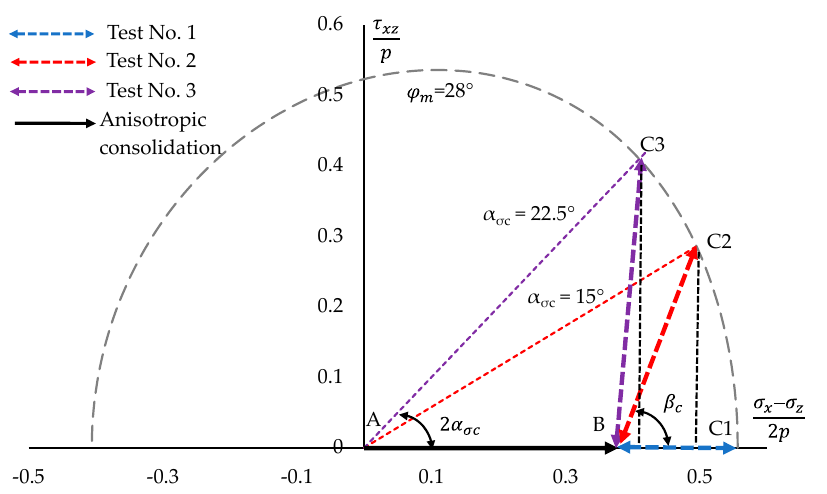
Figure 9. Schematic representation of stress paths imposed in the HCTA tests. Table 2. List and details of performed hollow-cylinder torsional